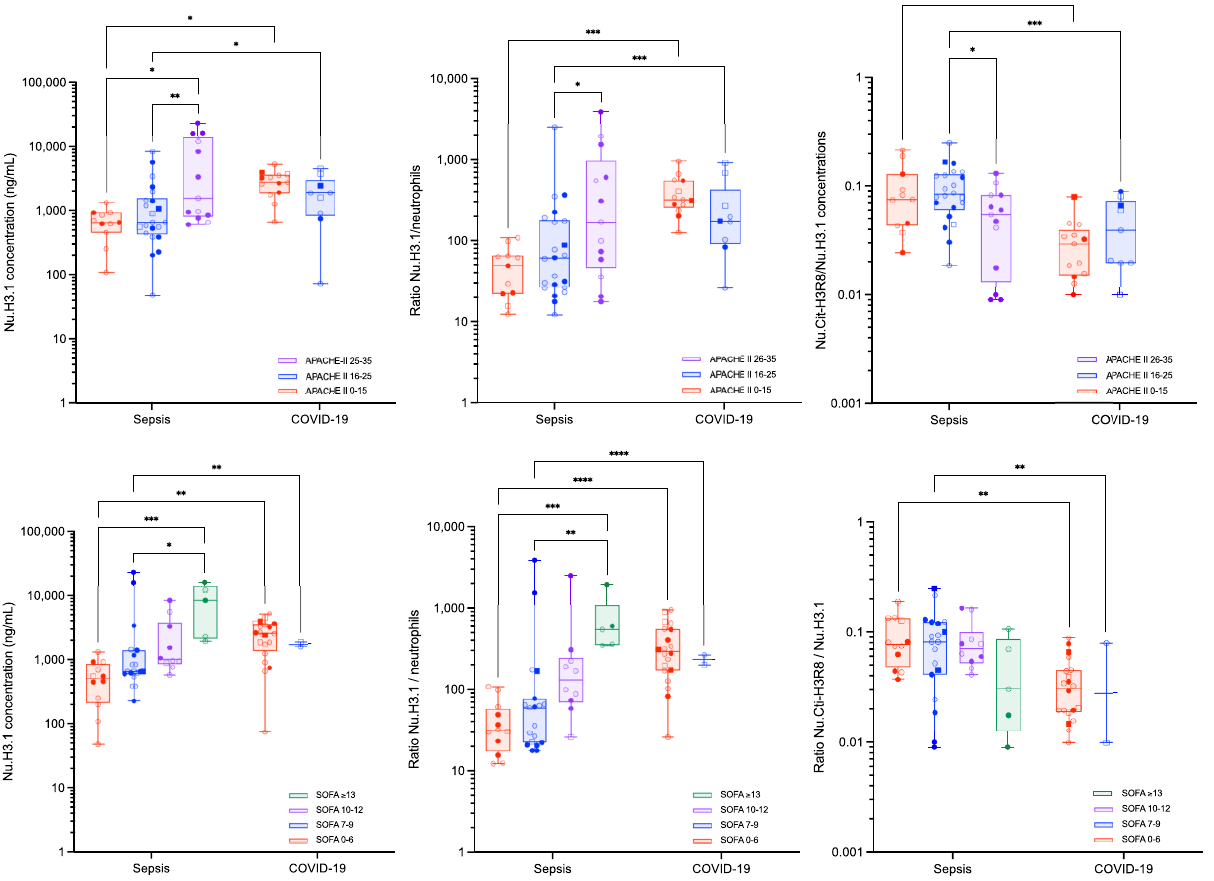
Figure 5. Comparison of nucleosome markers and derived ratio calculation according to APACHE-II and SOFA scores in septic shock and critical COVID-19 subjects. Boxes represent 25th–75th percentile with median. Whiskers represent min to max variation. Squares represent patients with a thromboembolic event, and non-transparent symbols represent dead patients. *, **, *** and **** represent p -values ≤ 0.05, ≤ 0.01, ≤ 0.001 and ≤ 0.0001, respectively. Only differences that are statistically significant are reported. Abbreviations: Cit-H3, citrullinated histone H3 (citrullinated in R2, R8 and R17); MPO, myeloperoxidase; NE, neutrophil elastase; Nu.Cit-H3R8, citrullinated H3R8-nucleosome; Nu.H3.1, H3.1-nucleosome.